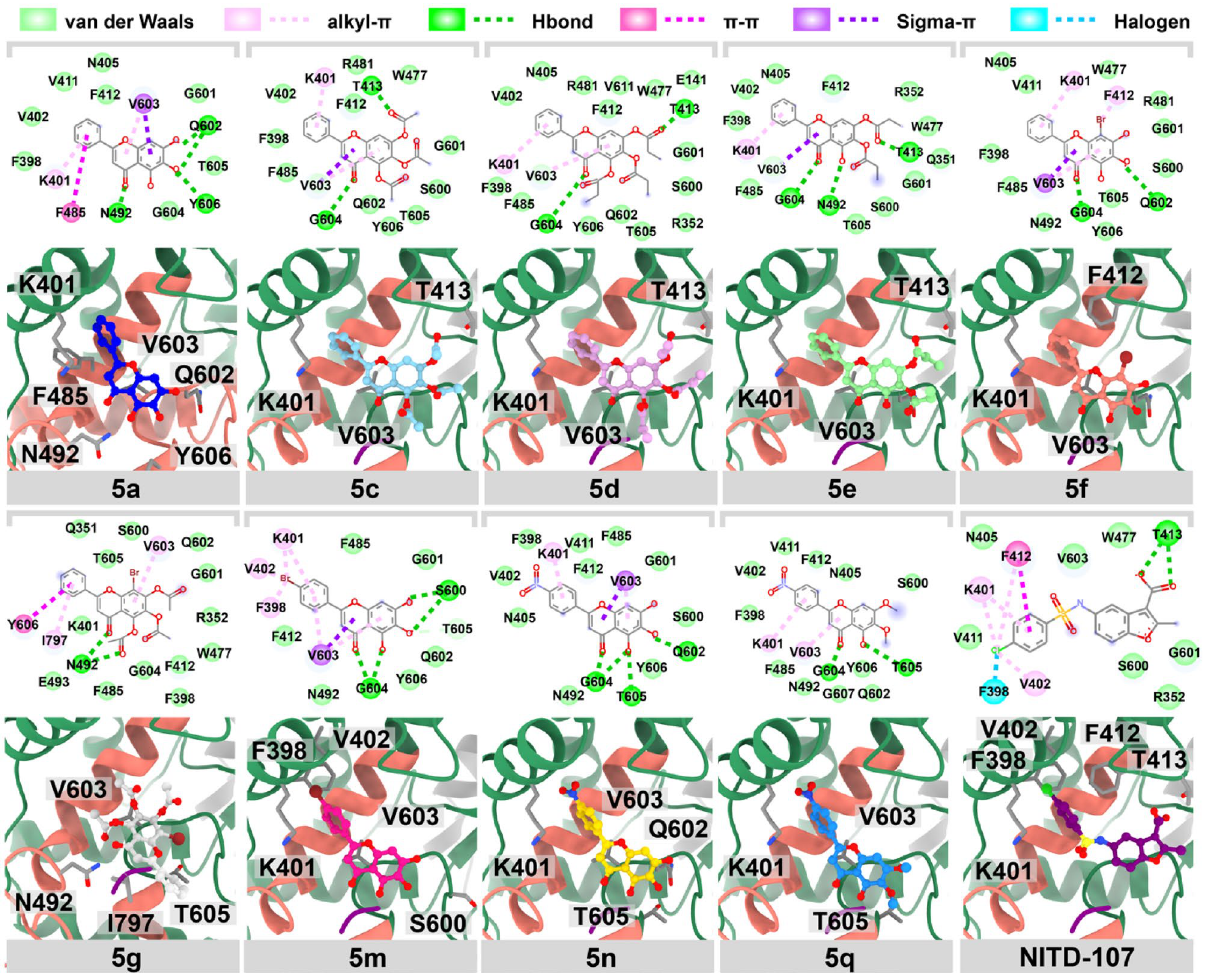
Figure 7. 2D interaction diagram and 3D view of potent flavone analogs and NS5 RdRp’s native inhibitor interacting in the binding pocket of NS5